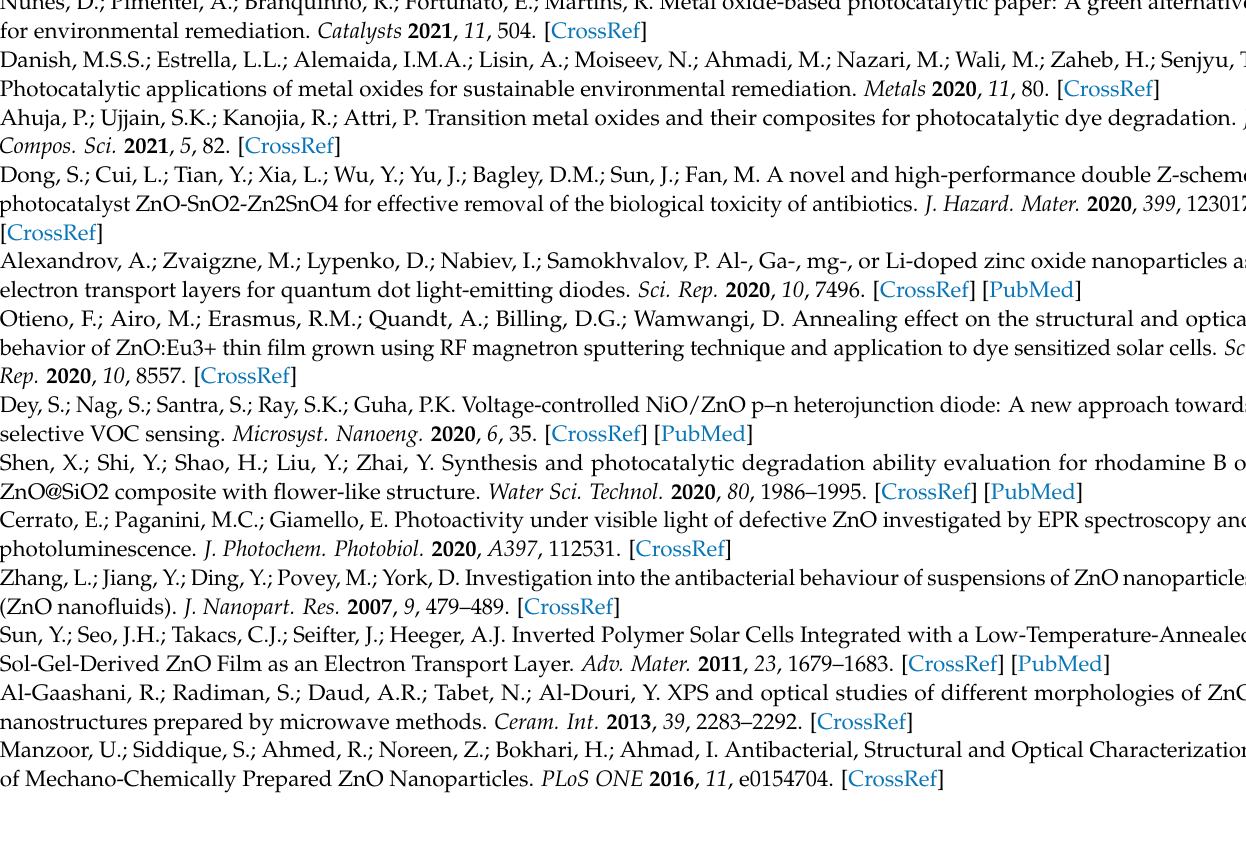
Figure S5: Photograph of degraded MB solutions; Figure S6: Photocatalytic degradation of MB during present and absent isopropanol as OH • scavenger; Figure S7: Concentration of anions during the photocatalytic degradation of MB; Figure S8: Photodegradation efficiency after recycling five times, comparison of the XRD patterns before and after five recycling tests and SEM image of the photocatalyst after five